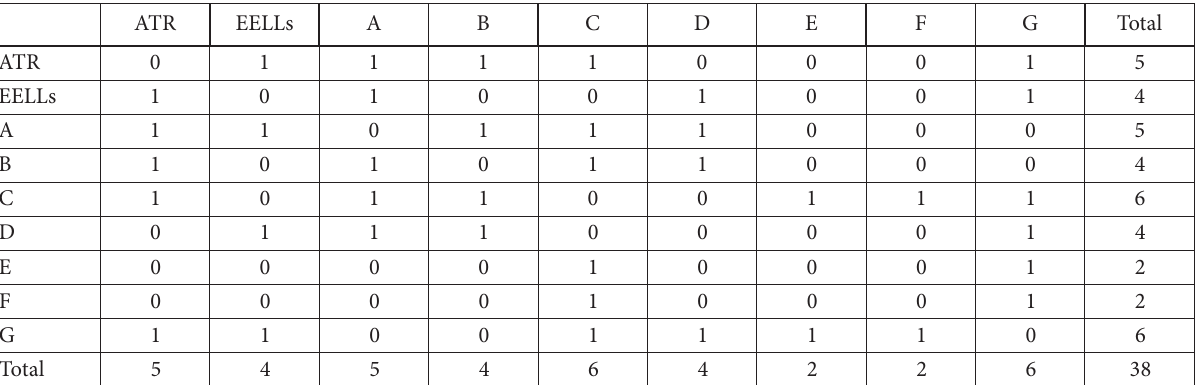
Table 1. The matrix of first-order ties